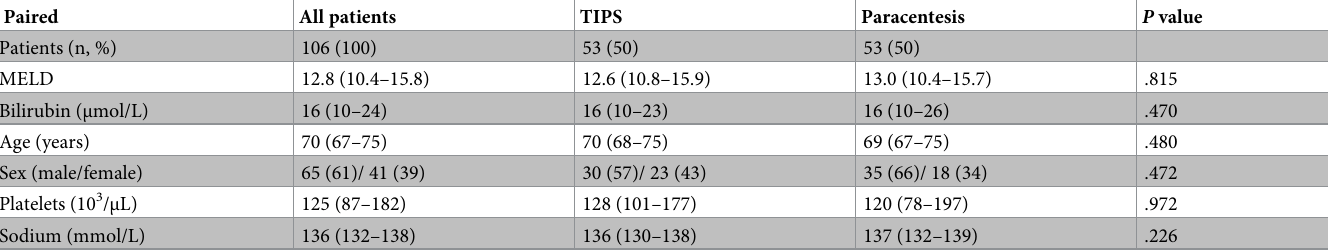
Table 4. Comparison of baseline characteristics between matched elderly TIPS patients and patients treated with paracentesis.